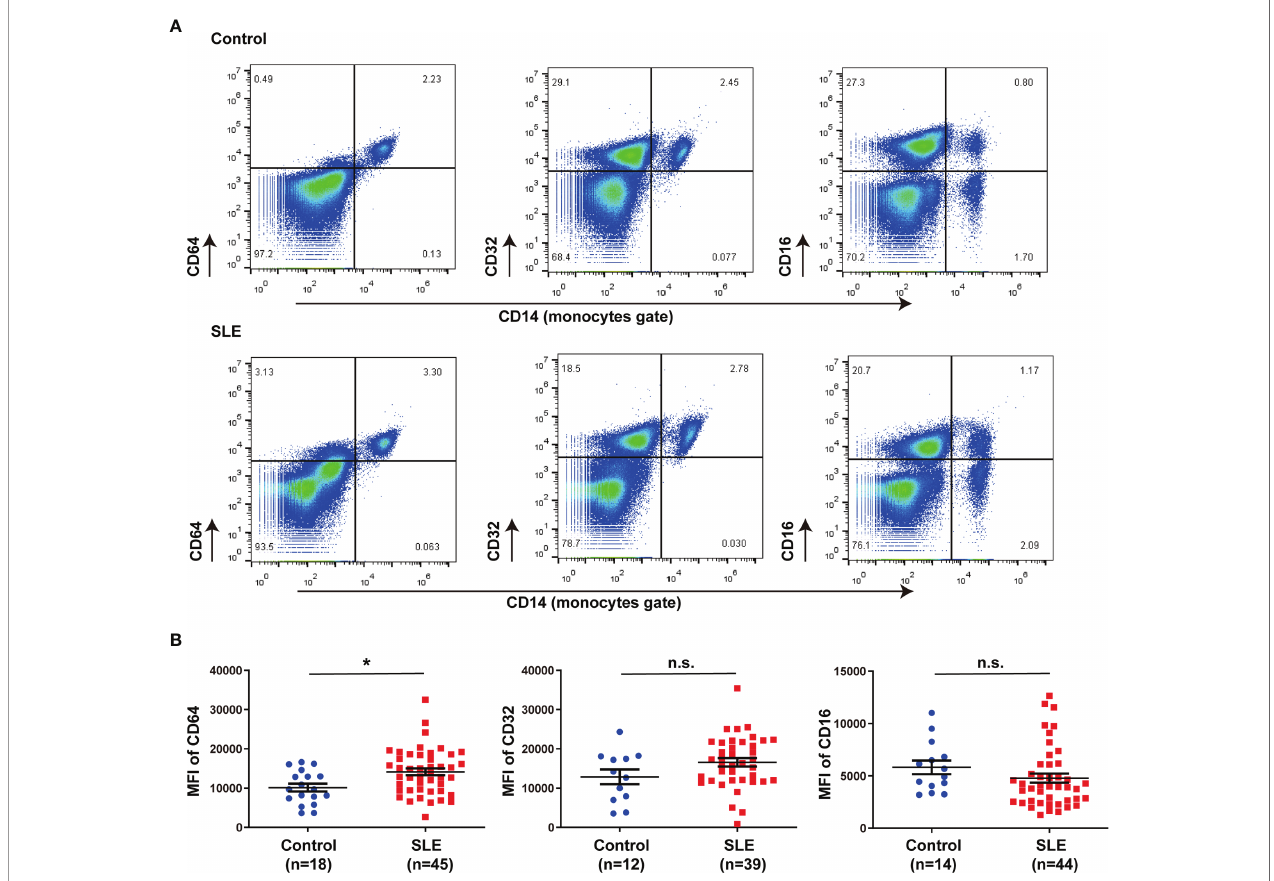
FIGURE 1 | CD64 expression in monocytes increased in SLE. (A) Representative fl ow cytometry of CD64, CD32 and CD16 expression on CD14 + monocytes of peripheral blood mononuclear cells from SLE patients and healthy controls. (B) Flow cytometry analysis of surface expression of CD64, CD32 and CD16 on circulating monocytes in healthy controls and SLE patients. Detection of CD64 expression comprises 18 healthy controls (male:female=2:16, age 40.33±3.03) and 45 SLE patients (male:female=5:40, age 40.78±2.21). CD32 data comprises 12 healthy controls (male:female=2:10, age 43.25±4.12) and 39 SLE patients (male:female=3:36 , age 41.31 ±2.35). CD16 data comprises 14 healthy controls (male:female=2:12, age 42.79±3.61) and 44 SLE patients (male:female=3:41, age 40.31±2.14). Bars represent the average mean fl uorescent intensity (MFI) of CD64, CD32 or CD16 on monocytes. Error bars represent standard deviation. *p < 0.05; ns, not signi fi